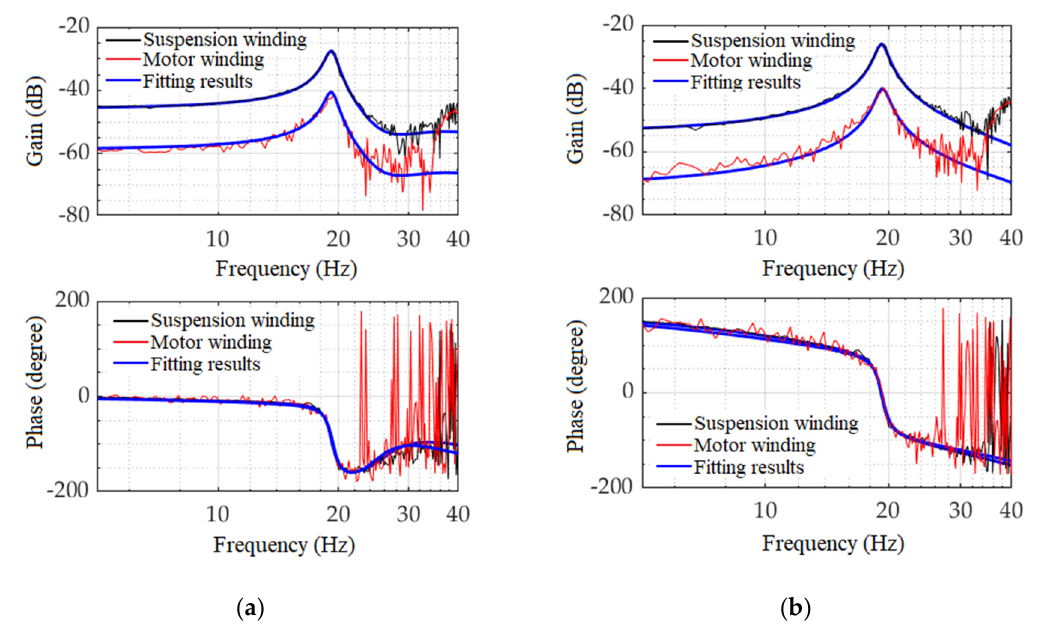
Figure 10. Measured and fitted responses of Bearing 1. ( a ) Measured and fitted response of Bearing 1 in the X -direction; ( b ) Measured and fitted response of Bearing 1 in the Y -direction.